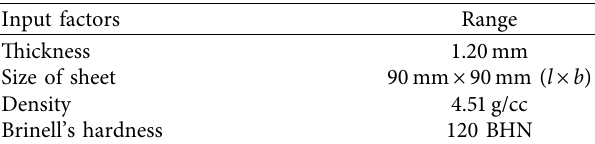
Table 1: The nomination composition of Cp-Ti alloy and the physical